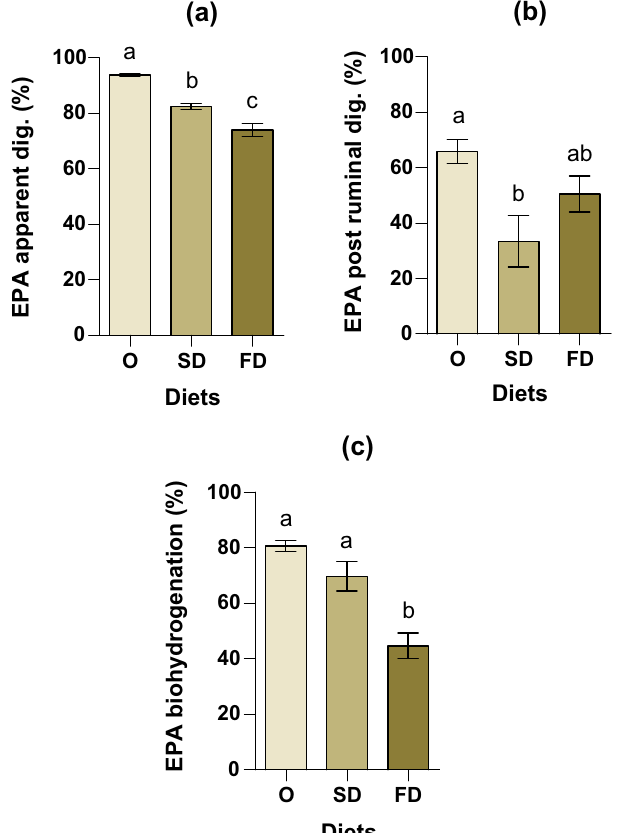
Figure 2. ( a ) EPA whole tract apparent digestibility (%), ( b ) EPA post ruminal digestibility (%) and ( c ) EPA biohydrogenation (%). Diets are represented as follow: O ( Nannochloropsis sp . oil), SD (spray-dried N. oceanica ) and FD (freeze-dried N. oceanica ). Least square means are presented in each bar with respective standard error of the mean. Different letters in each bar (a–c) indicate significant differences ( P < 0.05) among